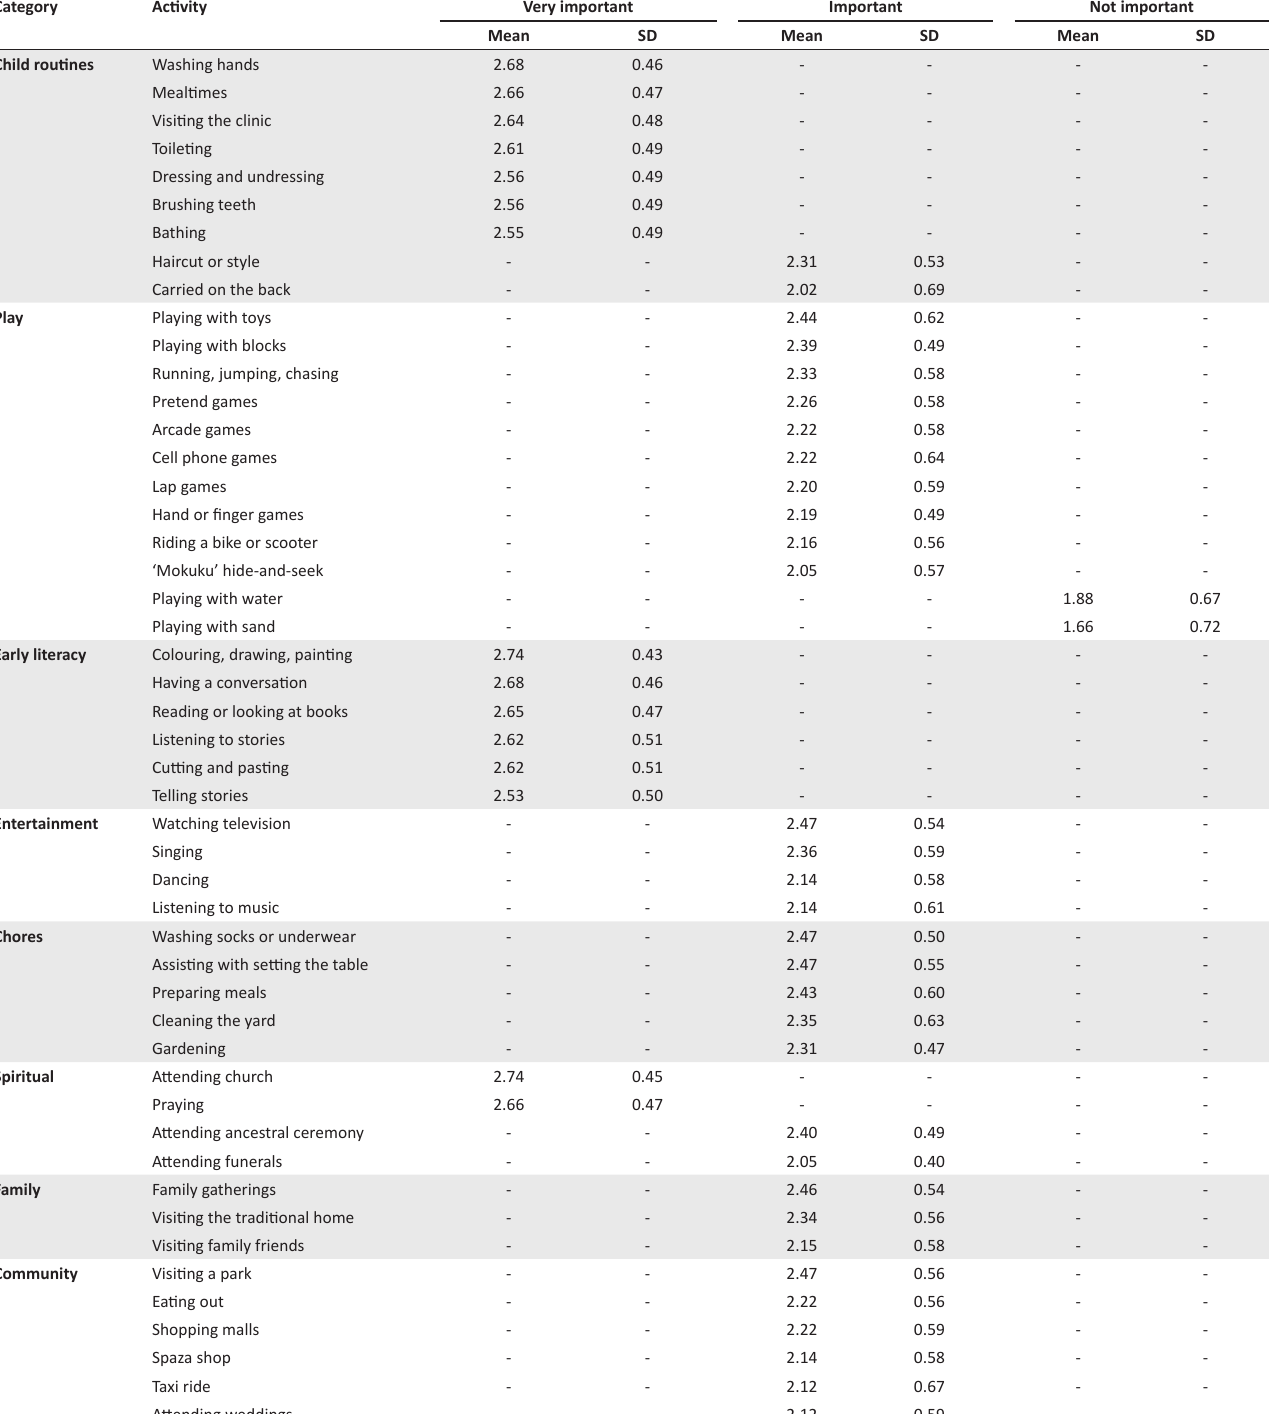
TABLE 2: Caregiver ratings on the importance of activities for learning. Category Activity Very